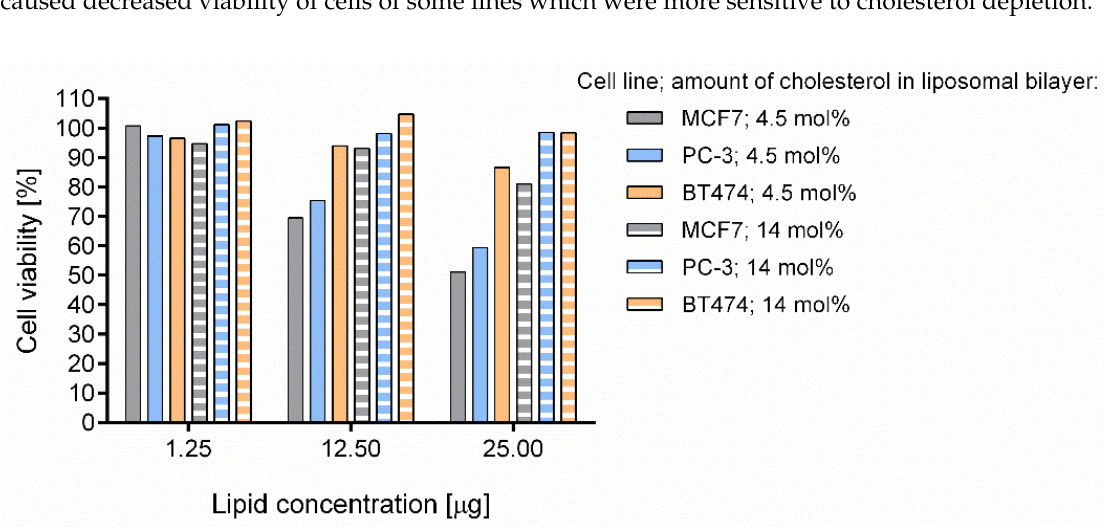
Figure 1. Viability of breast and prostate cancer cell lines after treatment with empty liposomes. Cells were treated with empty liposomes at concentrations corresponding to 1, 10 and 20 µ M of simvastatin liposomes for 48 h. Viability of cells was assessed by MTT (3-(4,5-dimethylthiazol-2-yl)-2,5-diphenyltetrazolium bromide) tetrazolium) reduction